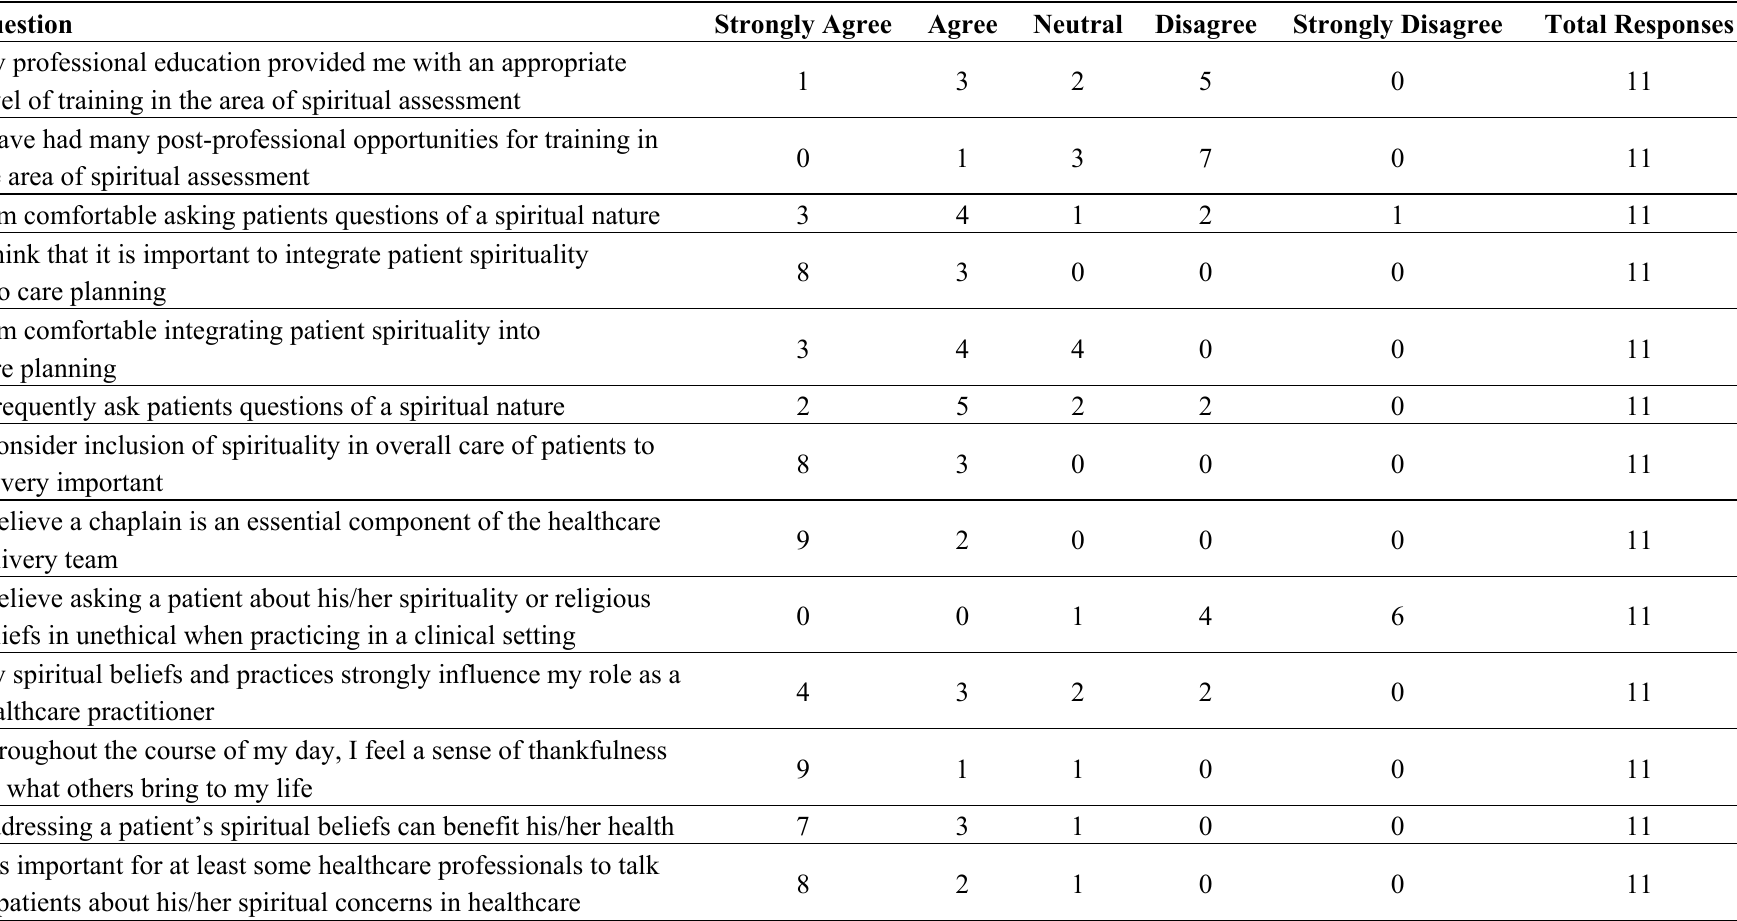
Table 1. Healthcare professional preparation, perspectives, and comfort regarding spirituality in patient care.